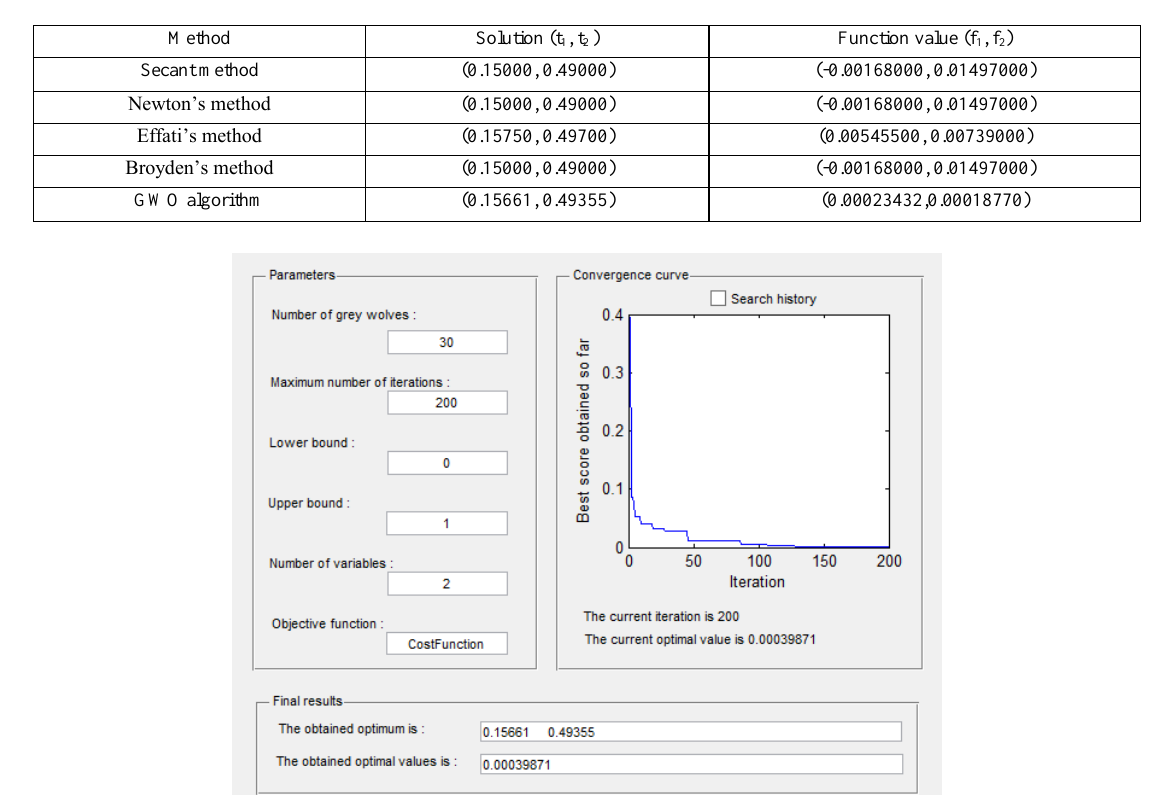
Table 3. Results for Problem 1